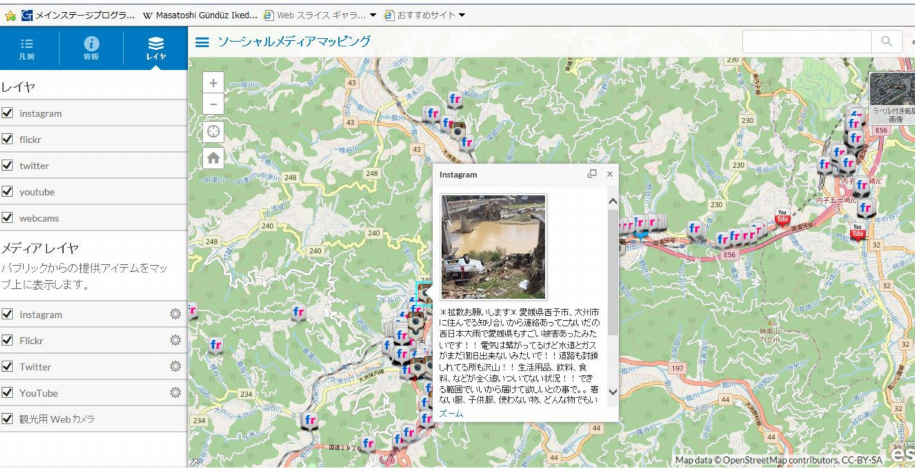
Figure 9. Submissions on Instagram concerning Ozu City, Ehime